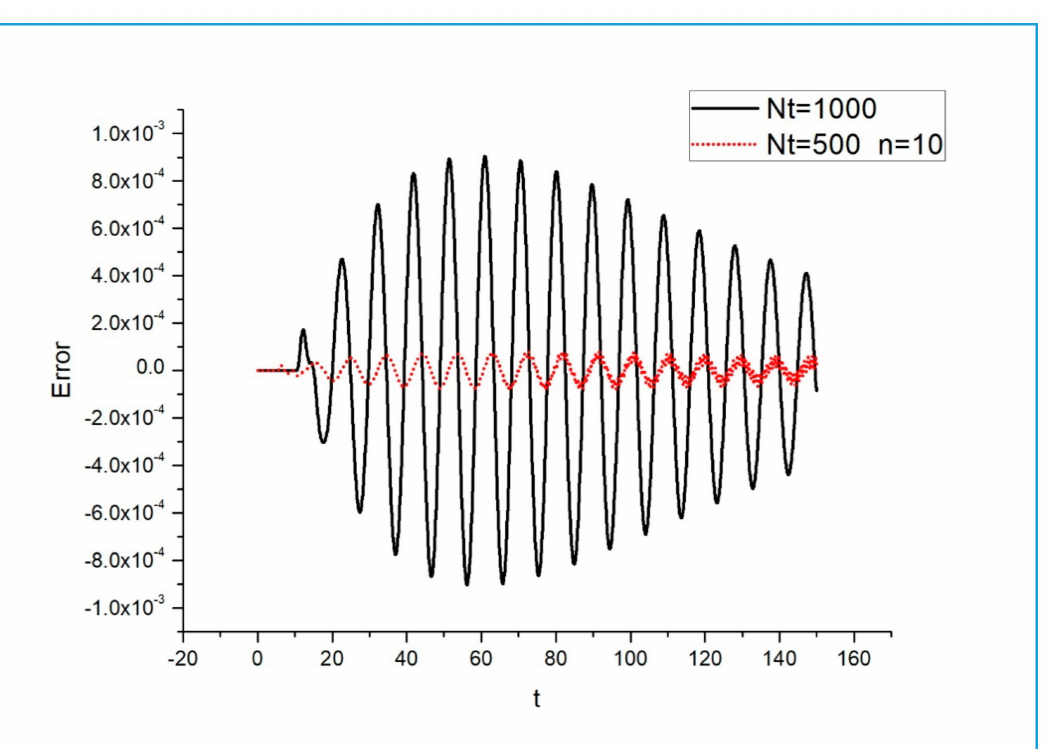
Figure 17. Errors of the two SMP methods (SMP and improved SMP) of m 2